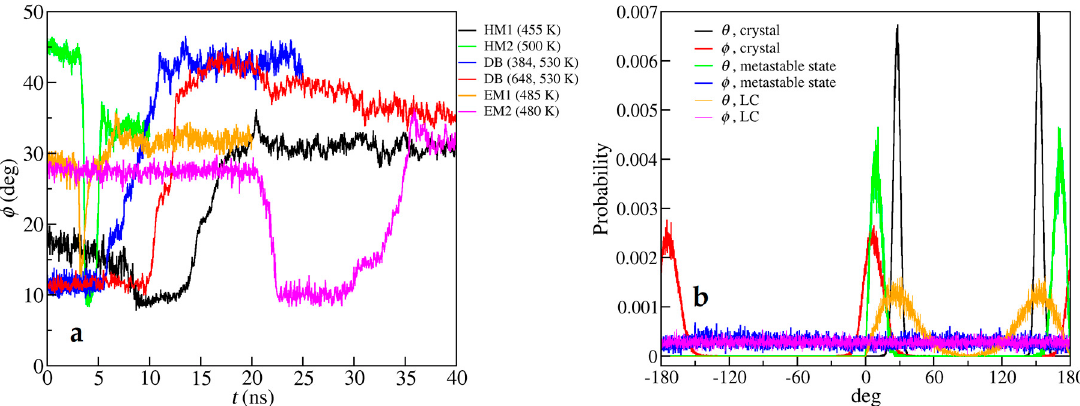
Figure 8. ( a ) The average angle between cations and the z axis ranging from 0° to 90° evolving with time at the solid ‐ LC transition temperature. ( b ) The angle distributions of cation orientation vectors in different stages of solid ‐ LC transitions of EM2 at 480 K, where θ is the polar angle ranging from 0° to 180°, and ϕ is the azimuth angle ranging from ‐ 180° to 180°.